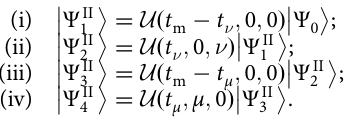
integrability. It is convenient to introduce the phase variable θ = 2 μ t ℏ , and to fi x t = ℏ π /(4 M ν ), with ℏ the reduced Planck μ / ν